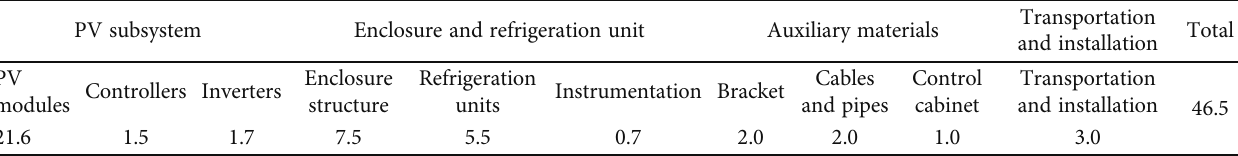
Table 5: Initial investment cost of the photovoltaic direct-drive refrigerated warehouse system (unit: thousand yuan). PV